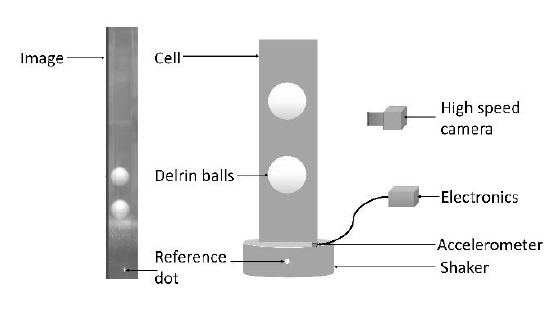
Fig. 1. The experimental setup. Two Delrin particles are placed in a nearly one-dimensional channel and driven vertically by a shaker. The positions and velocities of the two particles and the reference dot attached to the cell platform are extracted by analysis of images from the high-speed